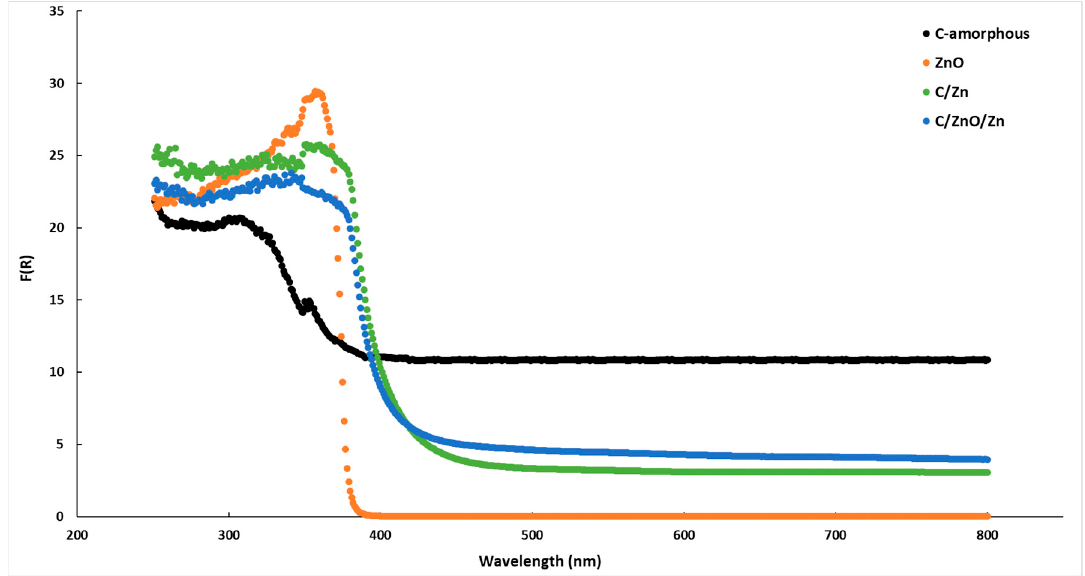
Figure 8. DR/UV-VIS spectra of the samples. Figure 8. DR / UV-VIS spectra of the